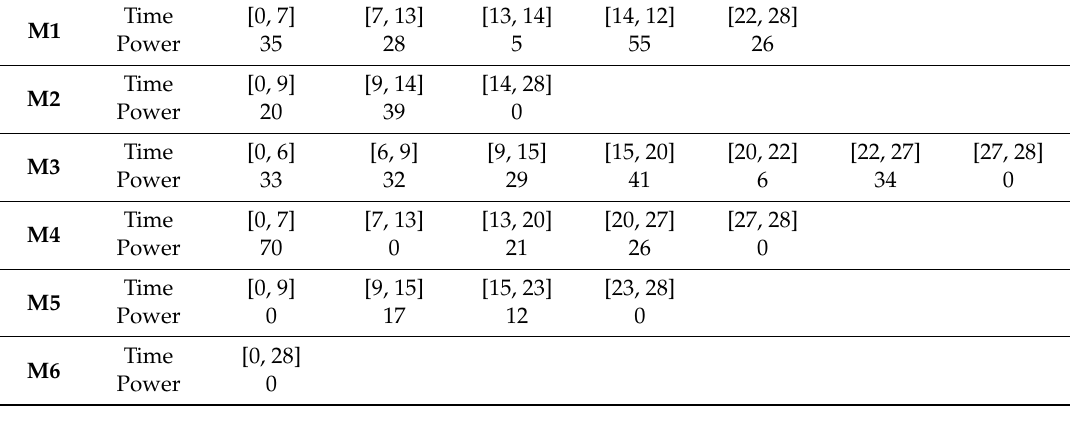
Table 2. Power data for the machines by time period.